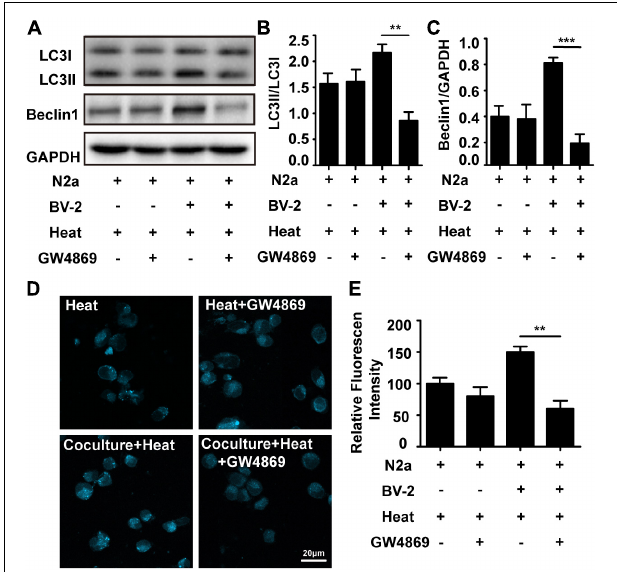
FIGURE 1 | Microglia accelerated heat stress-induced neuronal autophagy. N2a cells cultured alone or cocultured with BV-2 cells were pretreated with or without GW4869 (20 µ M, a commonly used inhibitor that can reduce exosomal secretion by decreasing nSMase2 activity) for 1 h and then subjected to heat stress at 42 ◦ C for 2 h, followed by a 6 h recovery period at 37 ◦ C. (A–C) The protein expression of LC3 and Beclin-1 in N2a cells was determined by Western blotting. Densitometric analysis was performed. (D,E) The autophagosomes in N2a cells were stained with MDC and subjected to confocal microscopy. Representative images and the analysis are shown. All the data are presented as the means ± SDs of at least three independent experiments. ** p < 0.01; *** p <